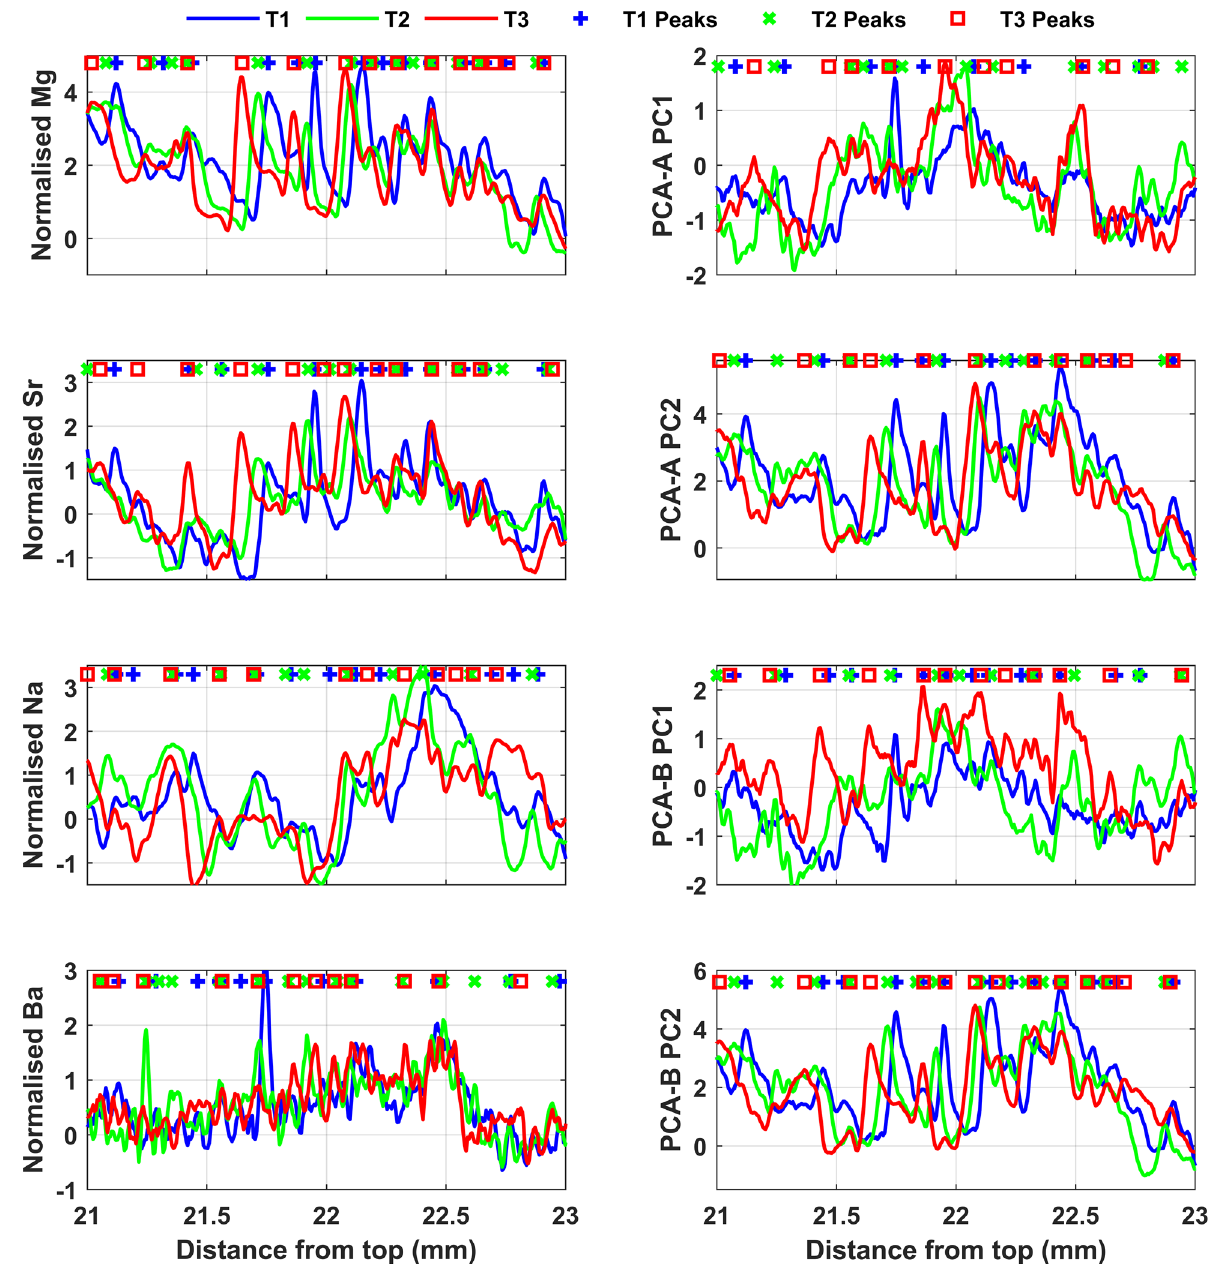
Figure 4. The locations of peaks identified on a group of LA-ICP-MS trace elements and the principal components. PCA-A includes [Mg, Sr, Na, Ba, P, Y] and PCA-B contains only [Mg, Sr, Na,